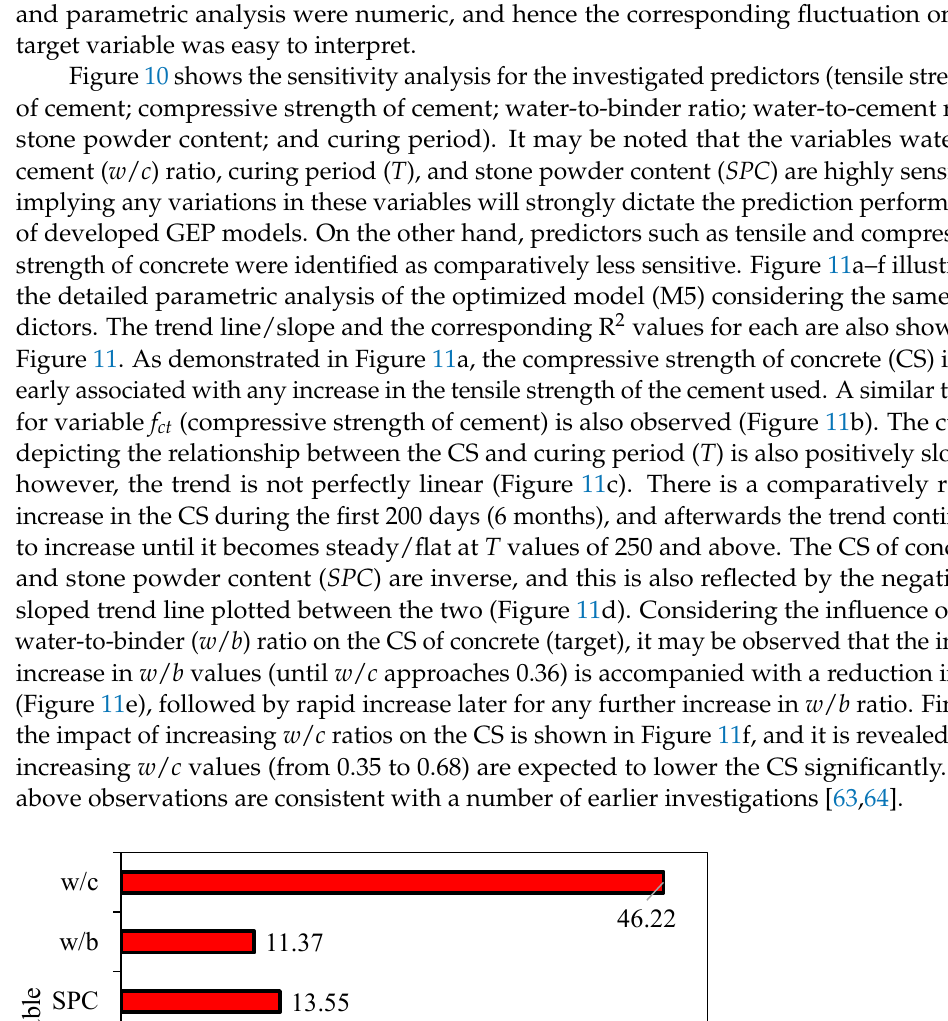
Figure 11. Parametric analysis of the optimized model ( a ) f ce ( b ) f ct ( c ) T ( d ) SPC ( e ) w / b ( f ) w / c .